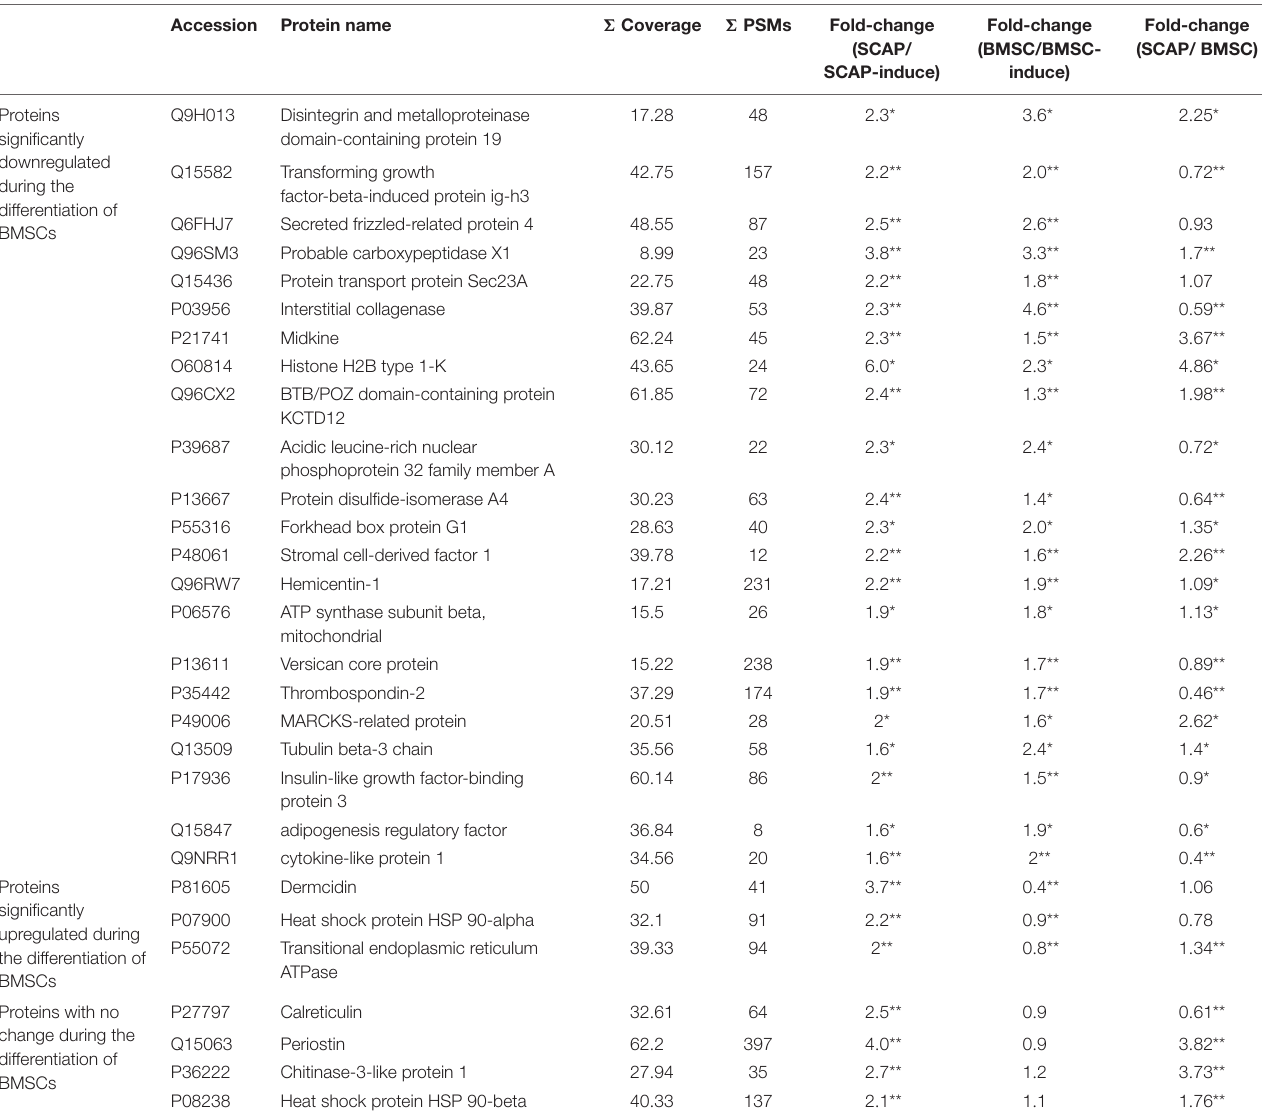
TABLE 2 | Significantly downregulated proteins during the odonto/osteogenic differentiation of SCAPs (fold change ≥ 1.5; * P < 0.05, ** P < 0.01). Accession Protein name (cid:54) Coverage (cid:54) PSMs Fold-change